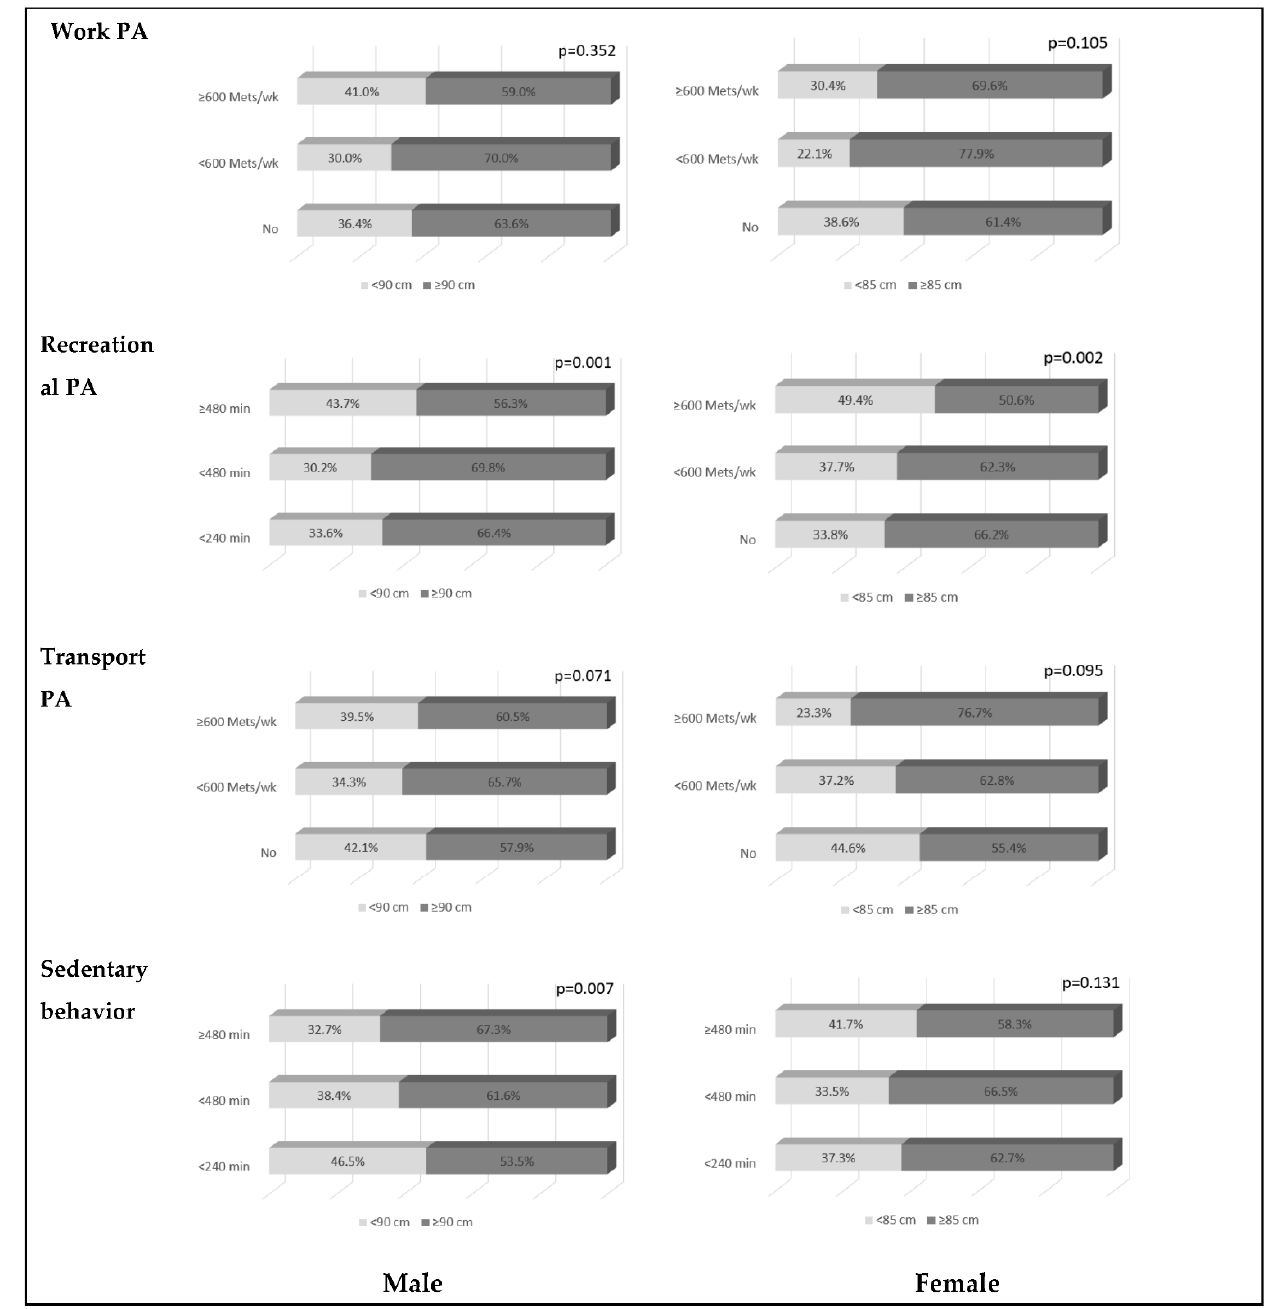
Figure 1. Distribution of WC at-risk group according to the amount of physical activity. Among obese adults, the rate of WC at-risk group according to physical activity level showed a significant difference in recreational PA. Levels of physical activity above 600 Mets/wk showed significantly lower rates of WC at-risk group, and men had significantly higher rates of WC at-risk group as sedentary behavior increased. Table 3. Risk analysis of recreational PA on waist circumference.